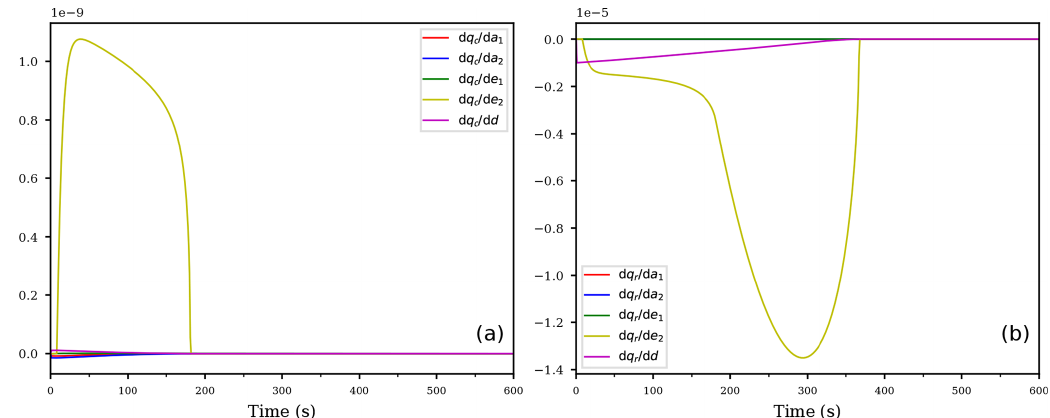
Figure 6. Temporal evolution of the derivatives of the cloud droplet mixing ratio q c (a) and the rain drop mixing ratio q r (b) with respect to the coefficients for the descending air parcel with evaporating cloud.